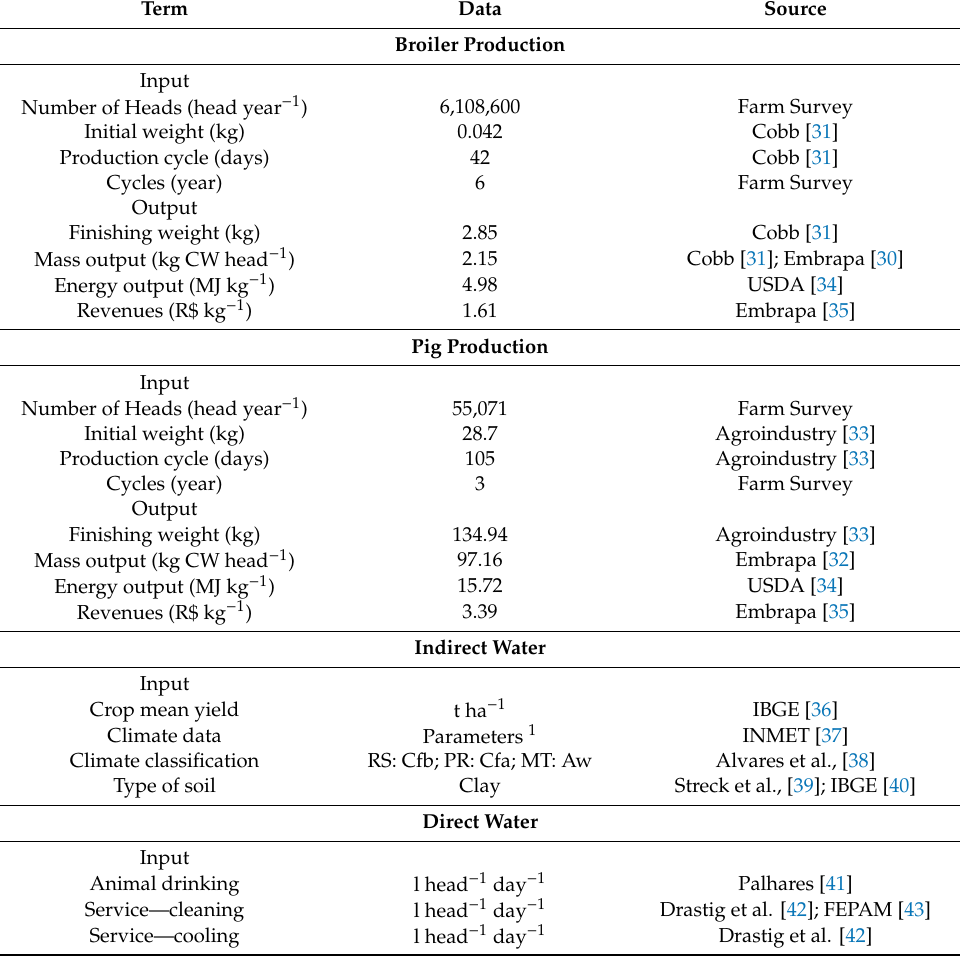
Table 1. Input data standard for pig and broiler production—year: